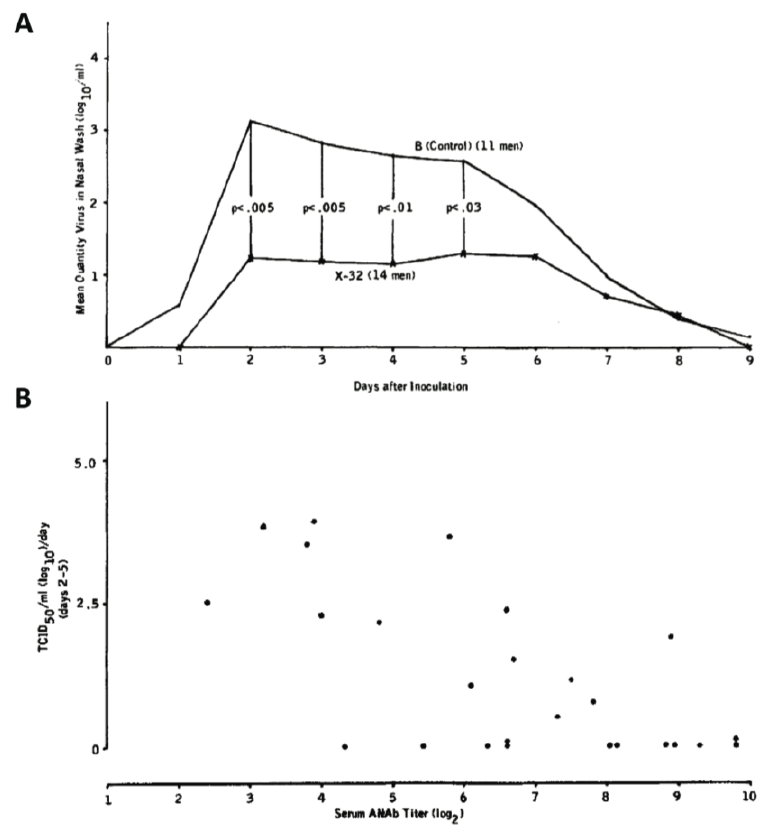
Figure 5. Historic evidence of NA-based protection in human vaccine experiments. ( A ) Male prisoners vaccinated with X-32 (H7N2) displayed significantly less nasal wash titers when intranasally challenged with H3N2 than those who were vaccinated with influenza B virus. ( B ) Level of virus in nasal wash specimens was inversely proportional to serum anti-NA antibody titer (taken with permission from Couch et al. , 1974)